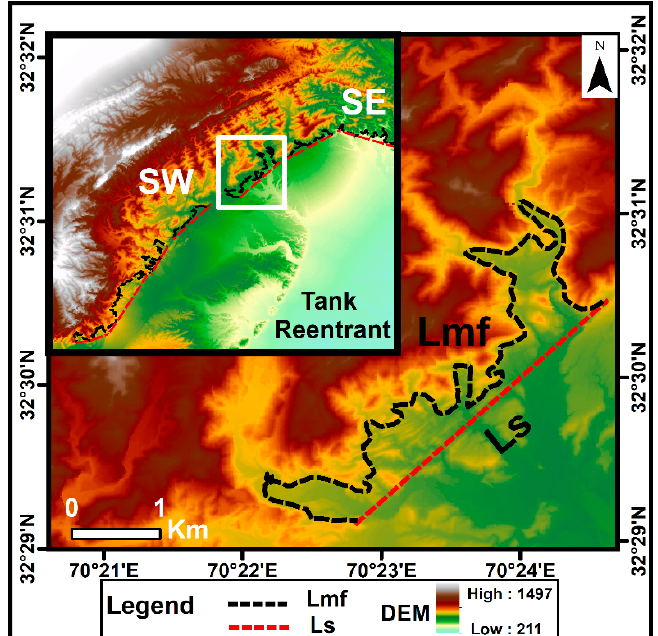
Figure 5. Calculation of the mountain front sinuosity index (S mf ) along the southwest and southeast segment of the Manzai Ranges. L s : straight-line length of the mountain front; L mf : length along the foot of the mountain front.